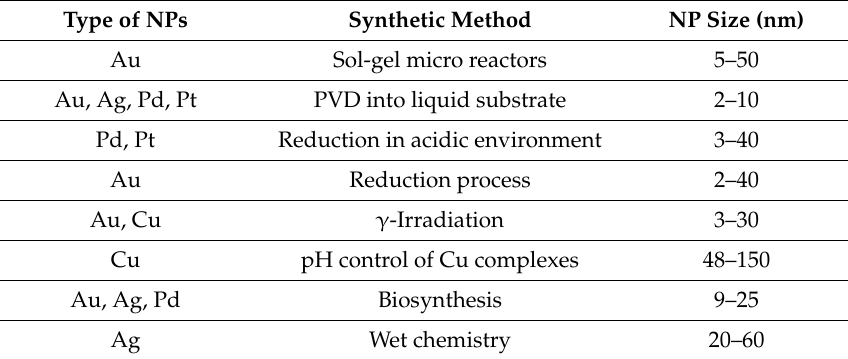
Table 1. Synthetic methods for di ff erent metallic NPs and their typical size distribution